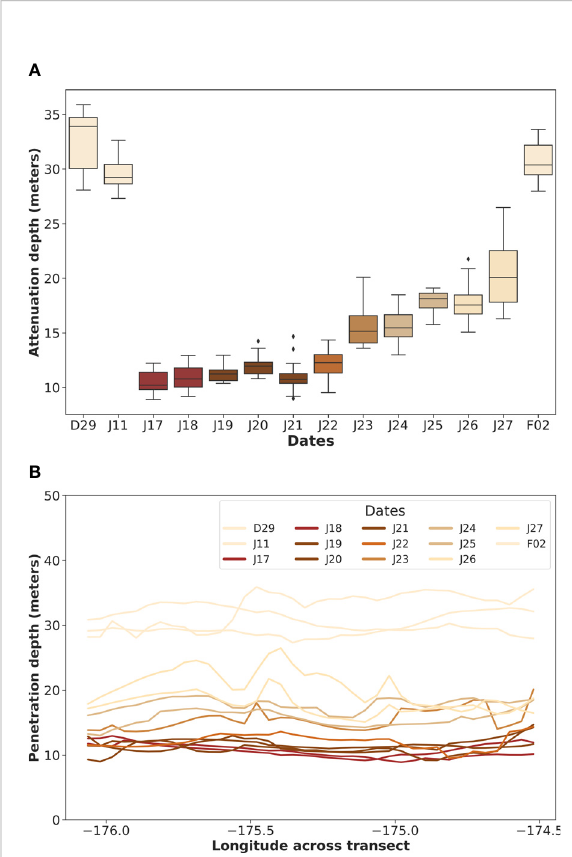
FIGURE 5 (A) Box and whisker plot showing light penetration depth (in meters) along the 20.73°Stransect (illustrated in Figure 1C within the patch) over time, from values of the CMEMS interpolated 1/ K d (490) data. (B) Time evolution of the penetration depth along 20.73°S from the earliest day of observations (17 January 2022) to the fi nal day (2 February